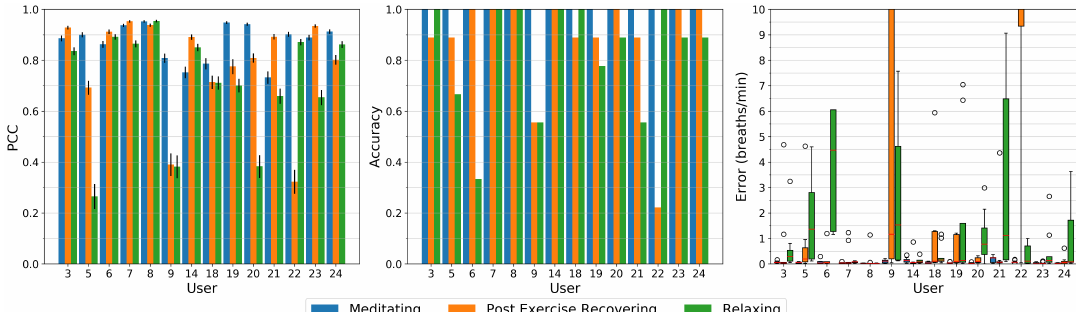
Figure 8. Left : The Pearson Correlation Coefficient (PCC) between the data from the Vernier respiration belt and our proposed system, for all users individually. The bars depict the means, while the black bars indicate the 99% confidence intervals. Data from paced breathing (15 breaths per minute) tends to result in high correlation between our system’s prediction and the belt’s output. Relaxed and post-exercise breathing tends to perform slightly worse. Middle : The accuracy of our proposed system compared to the respiration belt. Right : The error of the estimated respiratory rate compared to the respiratory rate from the respiration belt. Poor performance for users 9 and 22 stem mostly from larger movements during the recording.